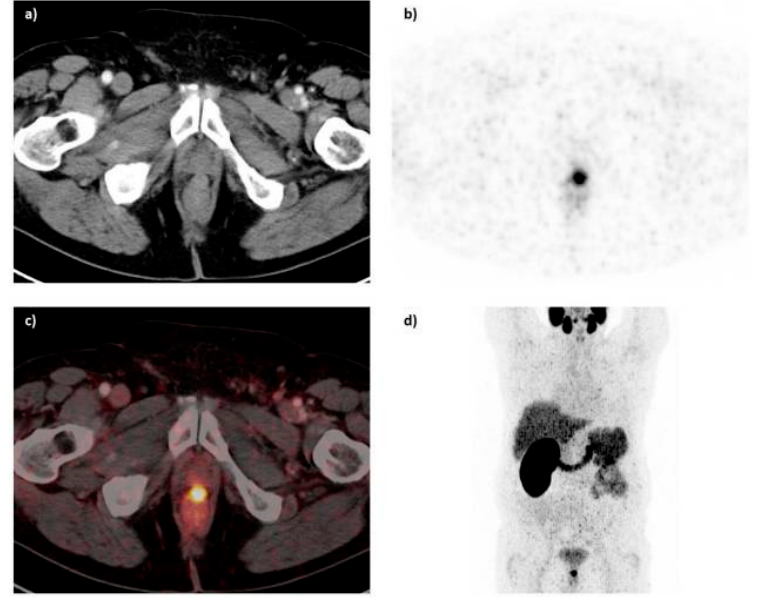
Figure 19. 68 Ga-PSMA-11 PET/CT image of a patient with locally recurrent prostate cancer (PSA 3.7 ng/mL) after radical prostatectomy (SUVmax 12.4) who received 140 MBq of the 68 Ga-labeled tracer molecule and was scanned at 1 h p.i.; ( a ) CT image; ( b ) PET image; ( c ) PET/CT fusion image; ( d ) MIP (Reprinted with permission of [145]).